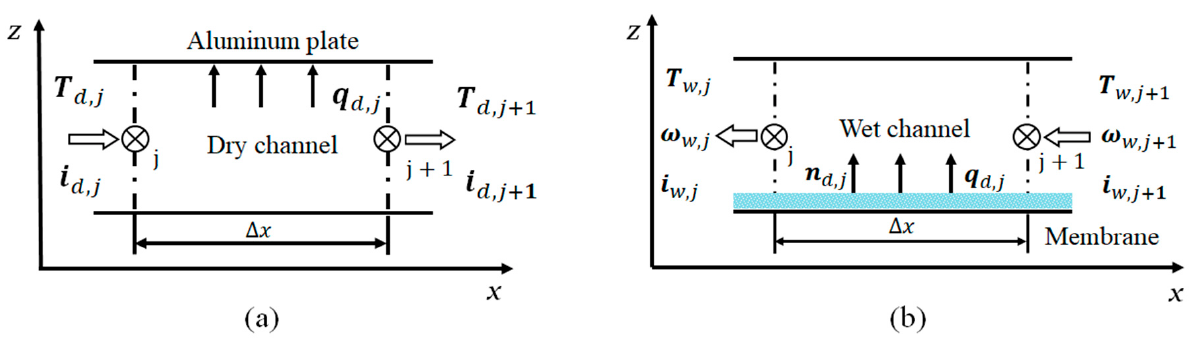
Figure 3. ( a ) The heat transfer process in dry channel; ( b ) the heat and mass transfer process in wet channel.